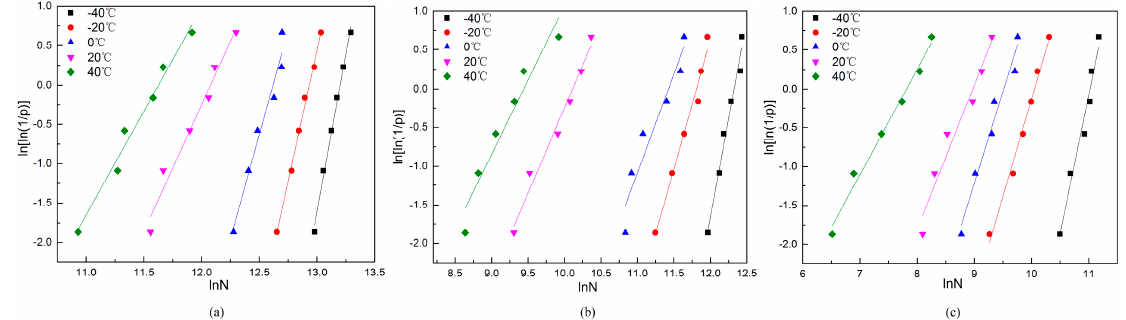
Figure 8. Two-parameter Weibull distribution test for fatigue life. ( a ) Stress level is S = 0.6; ( b ) stress level is S = 0.7; ( c ) stress level is S = 0.8.